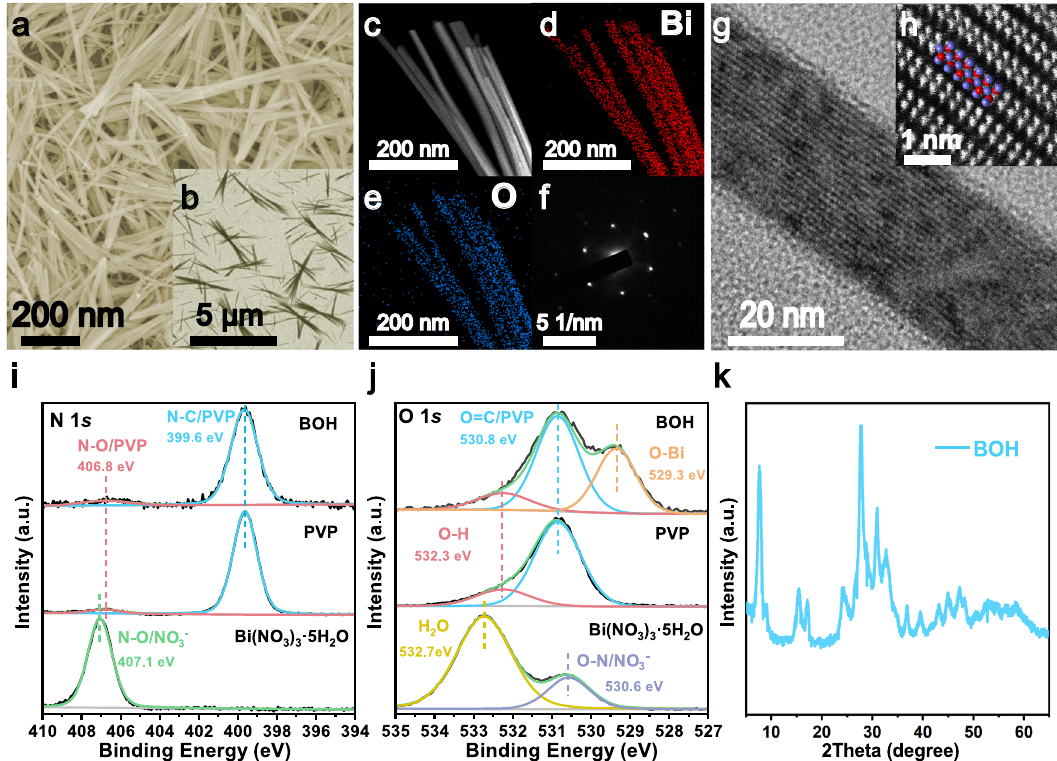
Fig. 2 Structure characterizations of BOH. a SEM image. b TEM image. c HAADF-STEM image. d , e EDS mapping for Bi and O, respectively. f SAED pattern. g HRTEM image. h Atomic-resolution AC HAADF-STEM image. And the overlaying model image showing the structure of [Bi 2 O 2 ] 2 + layer in Bi 2 O 2 (OH)(NO 3 ) (red balls, Bi atoms; blue balls, O atoms). i , j XPS spectra for N, O in BOH, PVP, and Bi(NO 3 ) 3 ·5H 2 O, respectively. k XRD